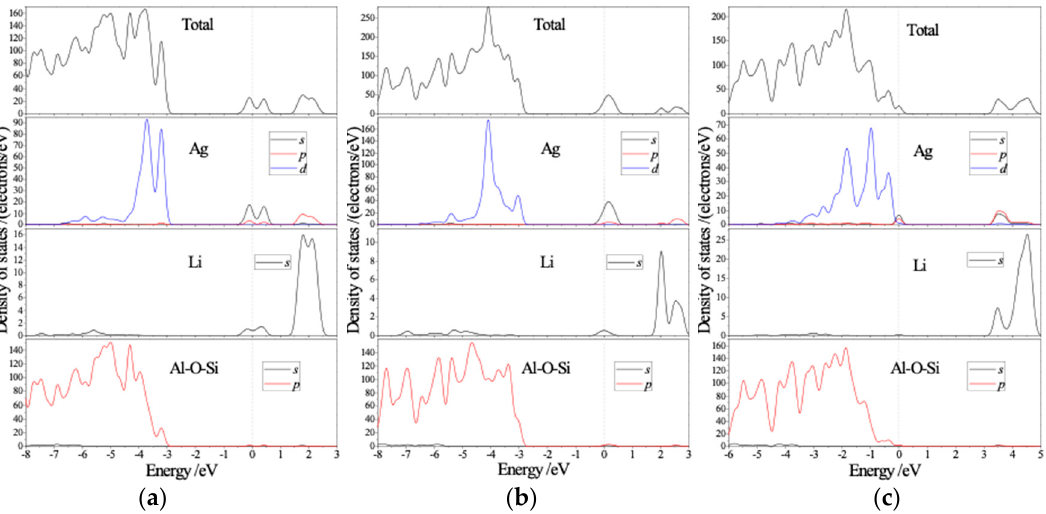
Figure 3. Calculated total and atomic projected density of states (DOS) for ( a ) aAg 0.29 Li 0.71 -LSX, ( b ) bAg 0.43 Li 0.57 -LSX and ( c ) cAg 0.29 Li 0.71 -LSX. The panels from up to down represents total DOS and partial projected density of state (PDOS) of Ag, Li and Al-O-Si framework atoms respectively. The Fermi energy level is set as the reference energy zero (vertical dash line).